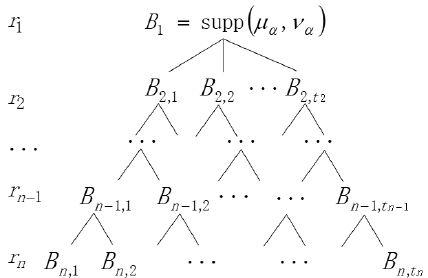
Figure 1. The tree structure of a closed G-V IFM .